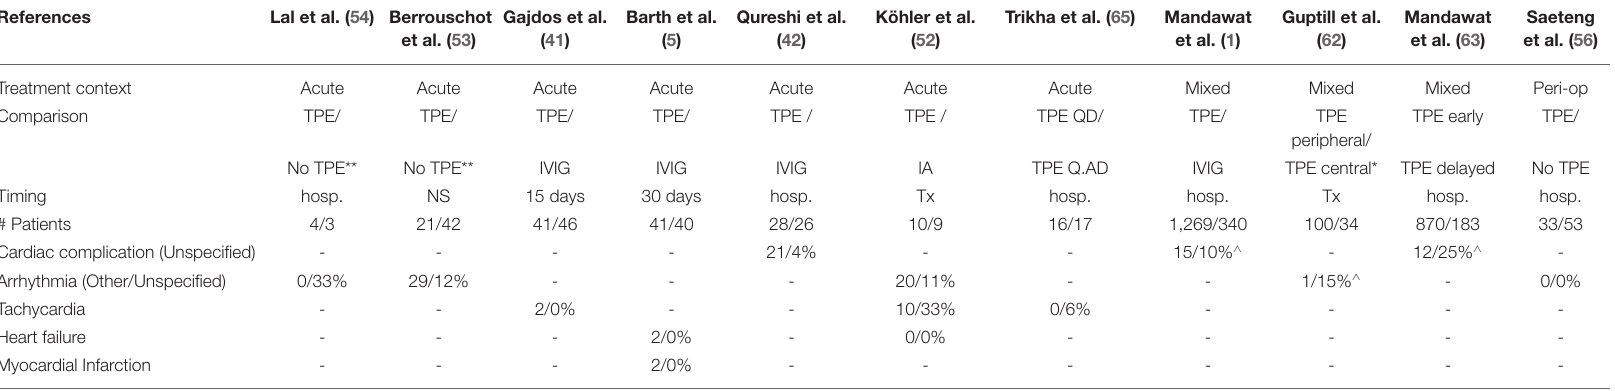
TABLE 9 | Comparative cardiac adverse event data for TPE in MG.